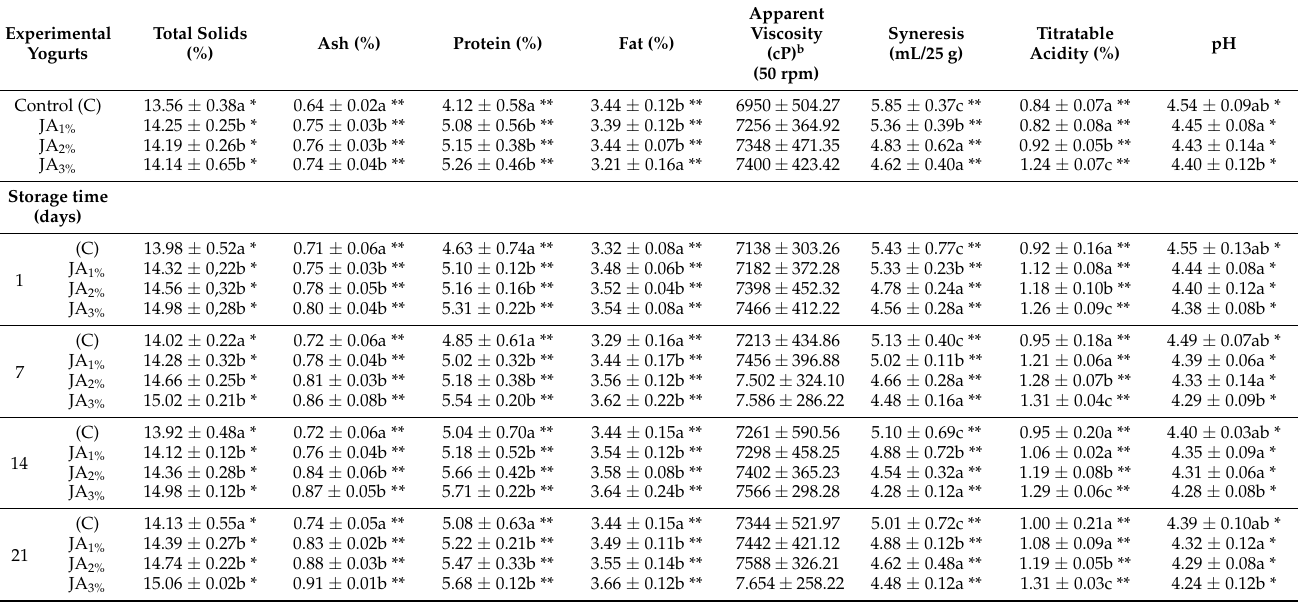
Table 1. The effect of JA ratios and storage periods on the physicochemical properties of the experi- mental yogurts (mean ±